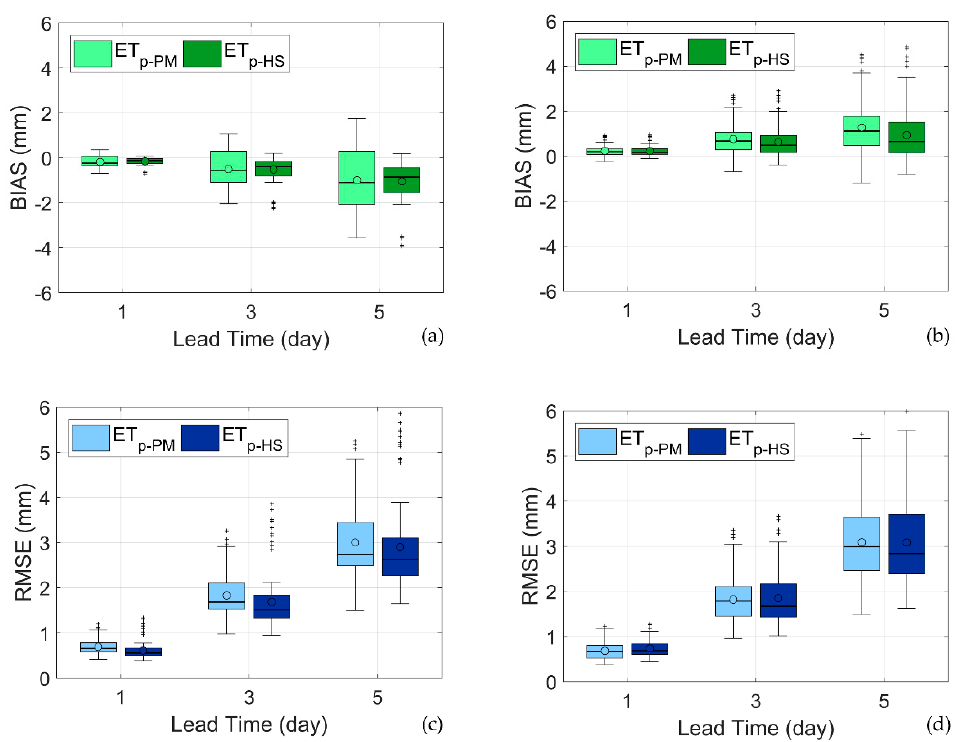
Figure 8. ( a , b ) BIAS (mm) and ( c , d ) RMSE (mm) of forecasted ET c accumulated in 1, 3 and 5 days for increasing lead time with reference to year 2014 ( a – c ) and year 2015 ( b – d ). The spread of the box plots refers to the variability of the statistical indices among the 18 AWS sites. The circles indicate the mean values. The central lines in the box indicate the median, the box edges are drawn at the 25th (p 25 ) and (p 75 ) percentiles. The whiskers extend to the most extreme data values, after excluding the outliers. Values are considered as outliers if they arelarger than p 75 + 1.5(p 75 – p 25 ) or smaller than p 25 - 1.5(p 75 – p 25 ).